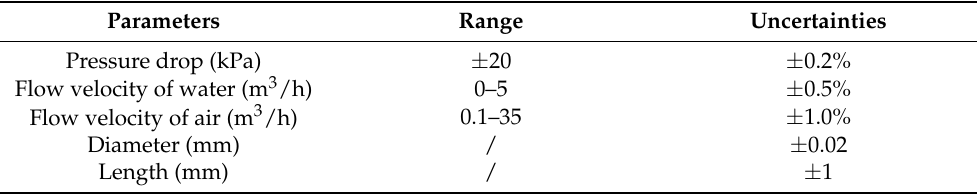
Table 2. The range and uncertainties of the measuring instruments and parameters.